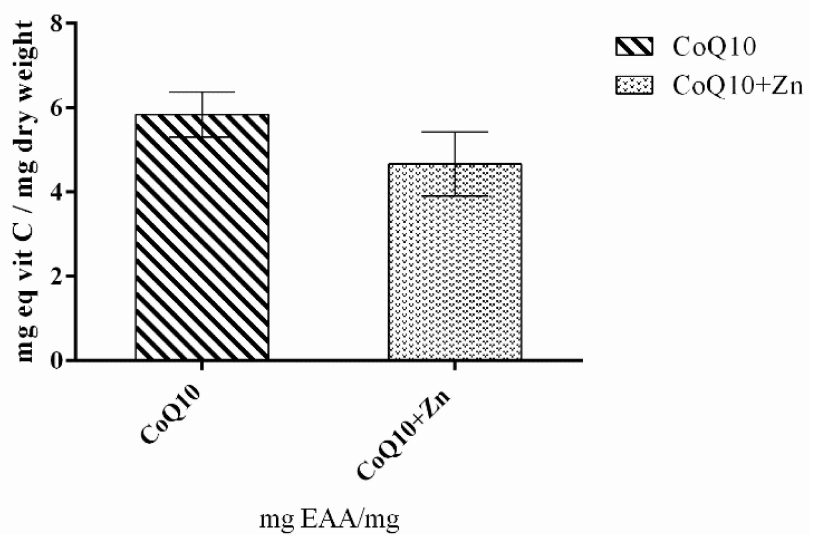
Figure 2. Antioxidant activity of CoQ10, and CoQ10 + Zn determined using the ferric reduction power assay (FRAP). The extracts were analyzed, and the values were compared with the standard curve constructed with ascorbic acid (0–60 µ